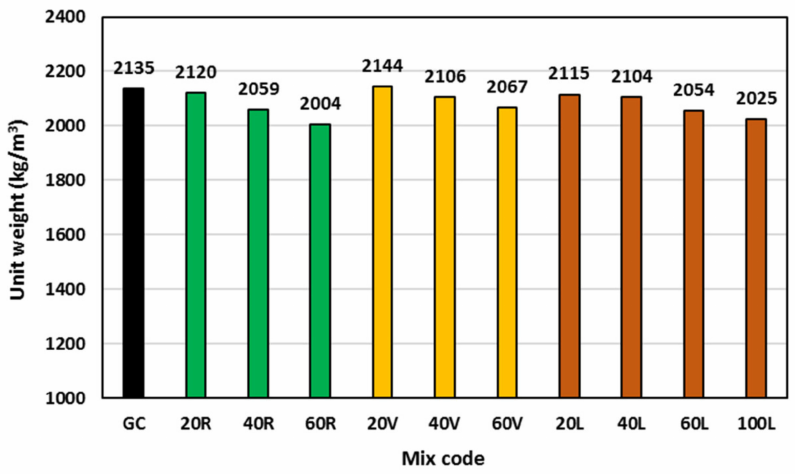
Figure 7. Unit weight of all geopolymer concrete